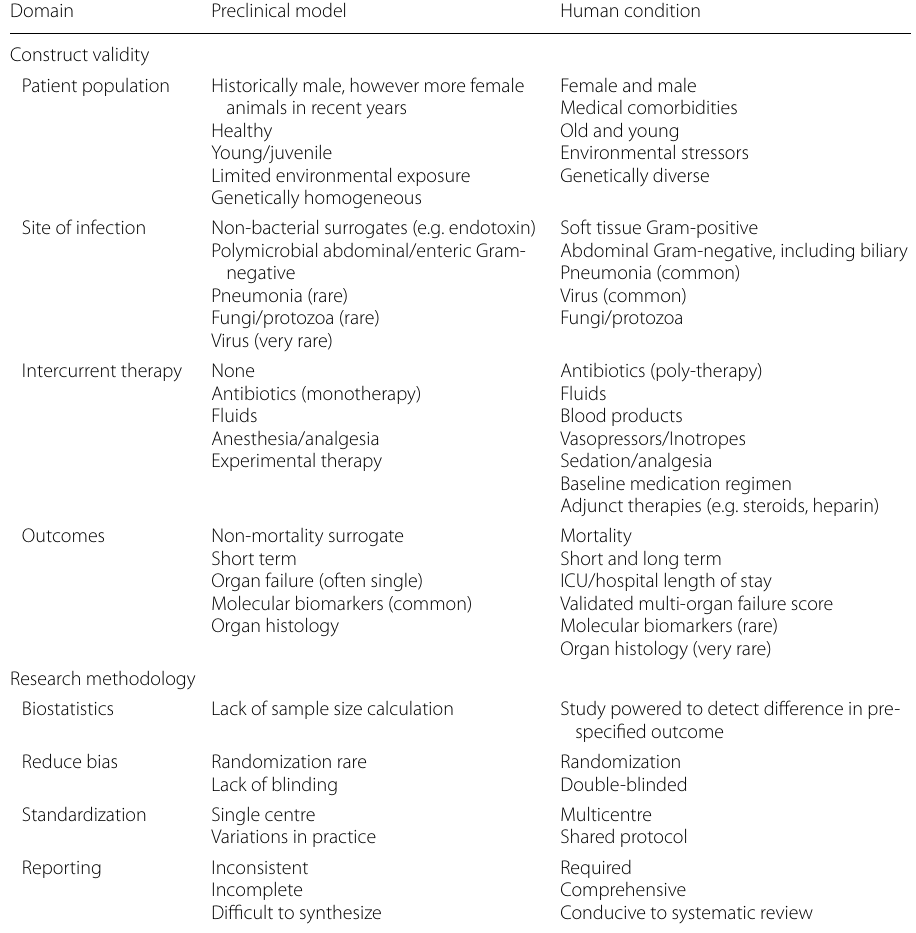
Table 1 Potential factors contributing to the lack of “bench‑to‑bedside” translational success of preclinical sepsis